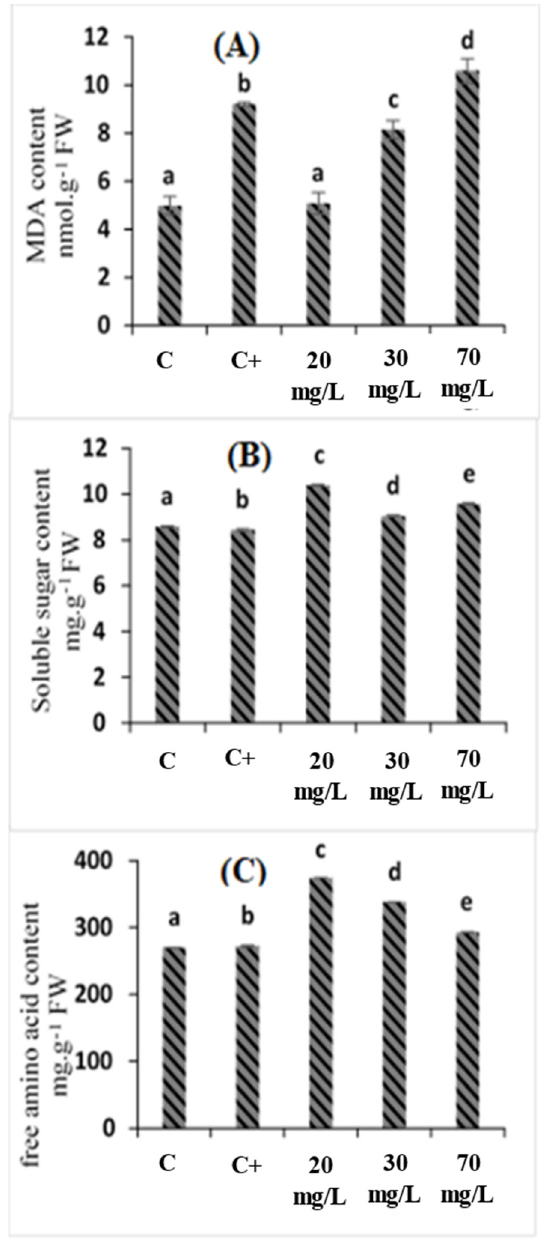
Figure 2. The effects of C. oxyacantha extract on malondialdehyde (MDA), soluble sugar, and free amino acid content in tomato plants under salt stress: ( A ) MDA content; ( B ) soluble sugar content; ( C ) free amino acid content. Different letters indicate significant differences between conditions ( p < 0.05) within conditions according to Tukey’s multiple range test.